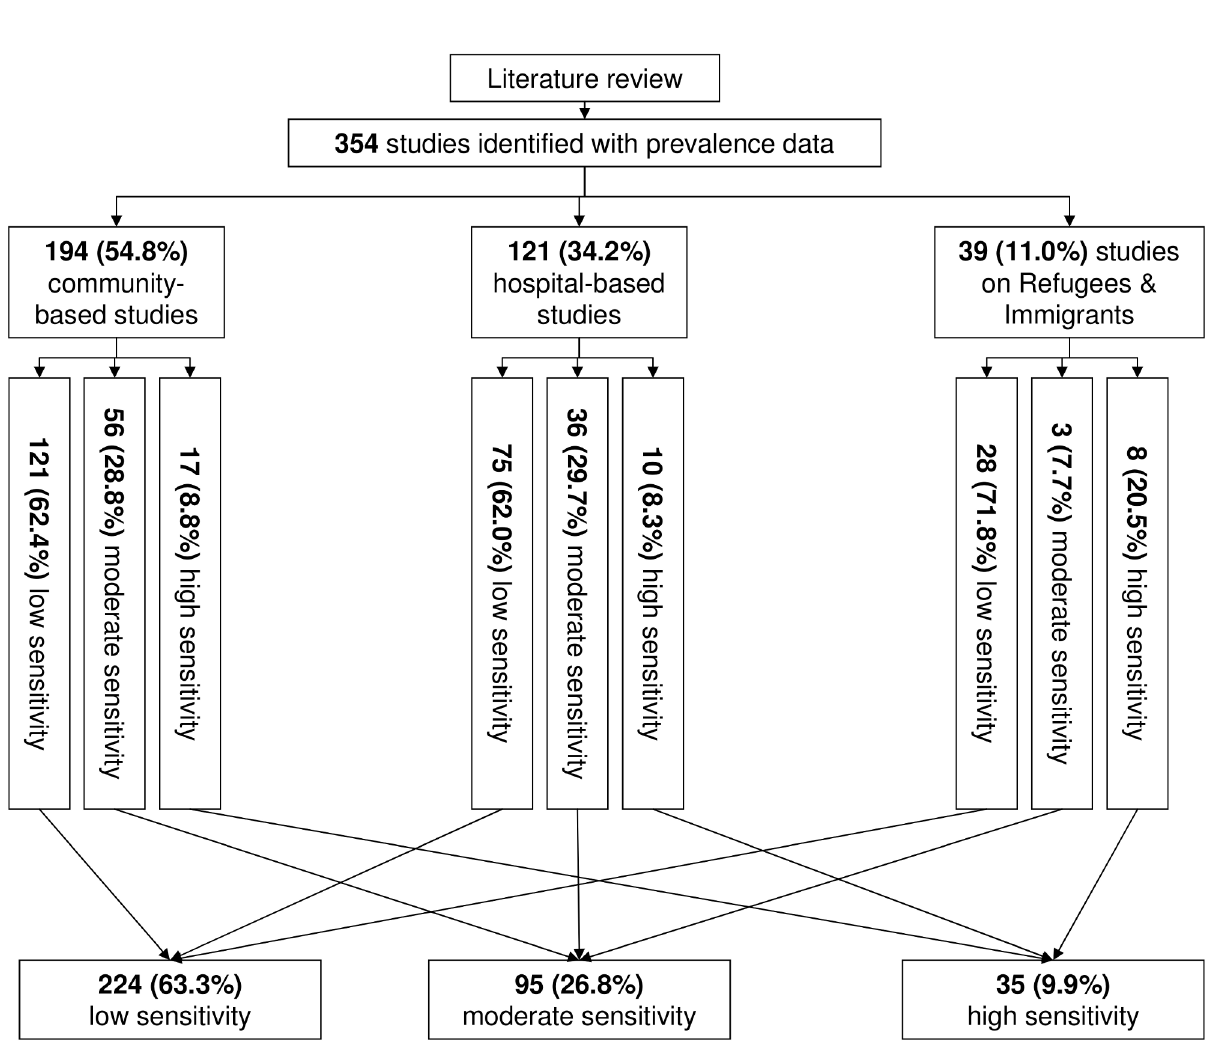
PLOS Neglected Tropical Diseases |